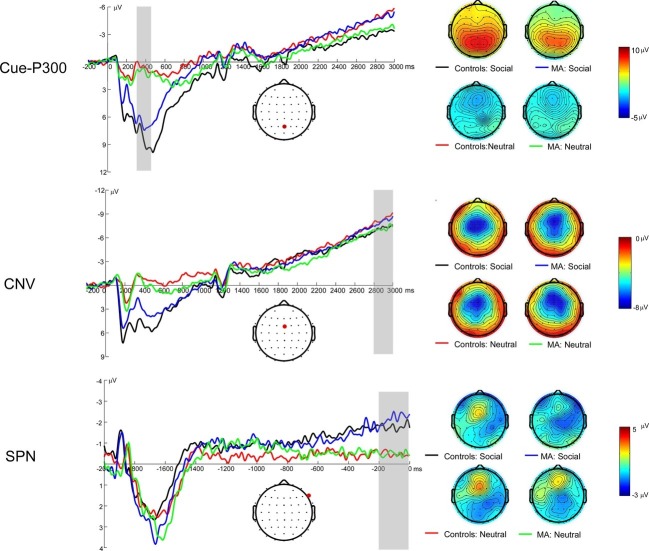
Left: Anticipatory ERP responses to social incentive and neutral trial conditions on SID. The Cue-P3 was scored as the average activity from 300 to 450 ms following cue onset (top). The CNV was scored as the average activity from 2,800 to 3,000 ms following cue onset (middle). The SPN (bottom; 200–0 ms prior to feedback onset) was scored as the average in the shaded window. Right: The topmap scalp distributions of the incentive and neutral trials for the Cue-P3 (top), CNV (middle), and SPN (bottom) for SID.